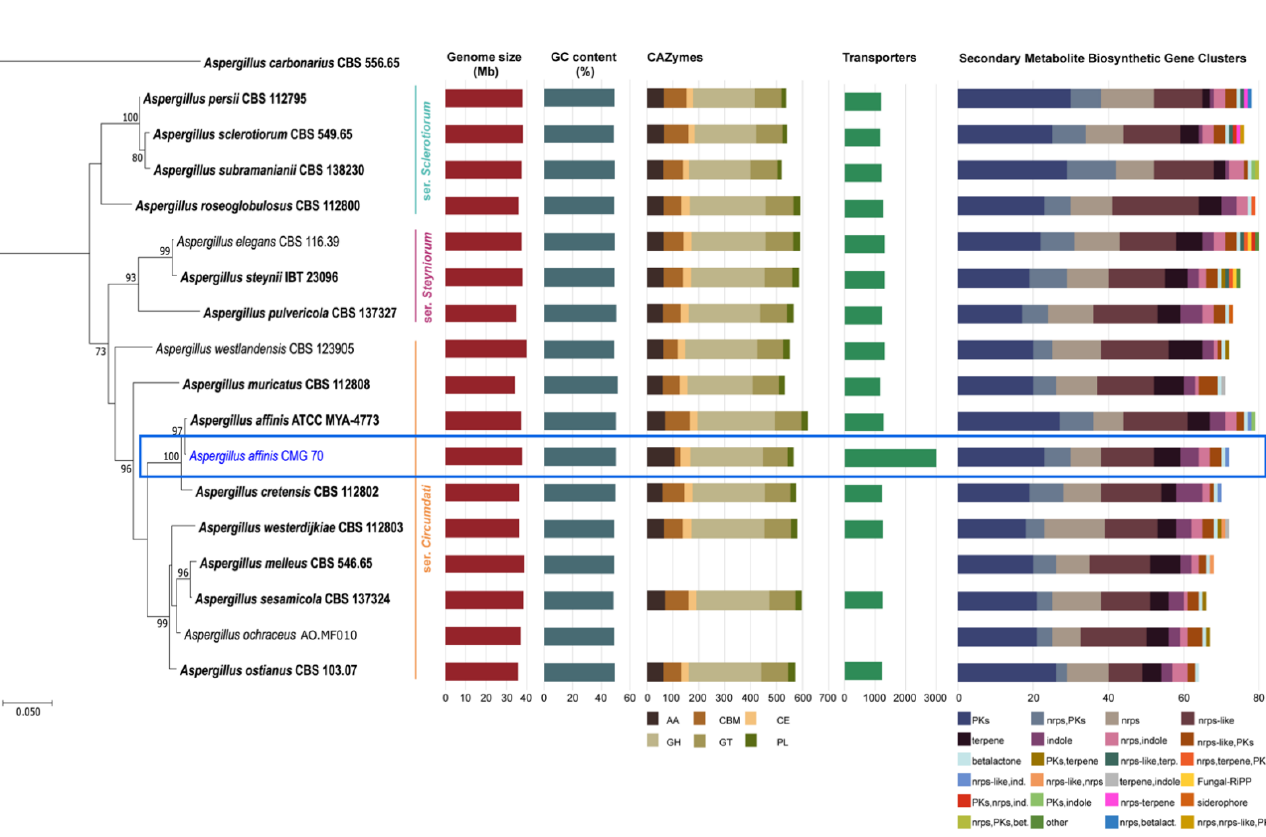
Figure 2. Phylogenetic relationship of 16 Aspergillus species from the section Circumdati based on ITS and tub2 sequence data and inferred using the Maximum Likelihood method under Tamura 3-parameter model. The tree is drawn to scale, with branch lengths measured in the number of substitutions per site and rooted to Aspergillus carbonarius (CBS 556.65). Bootstrap values ( ≥ 70%) are shown at the nodes. Ex-type strains are in bold and the strain under study is in blue. The number of carbohydrate-active enzymes, transporters and biosynthetic gene clusters are indicated using bar graphs.